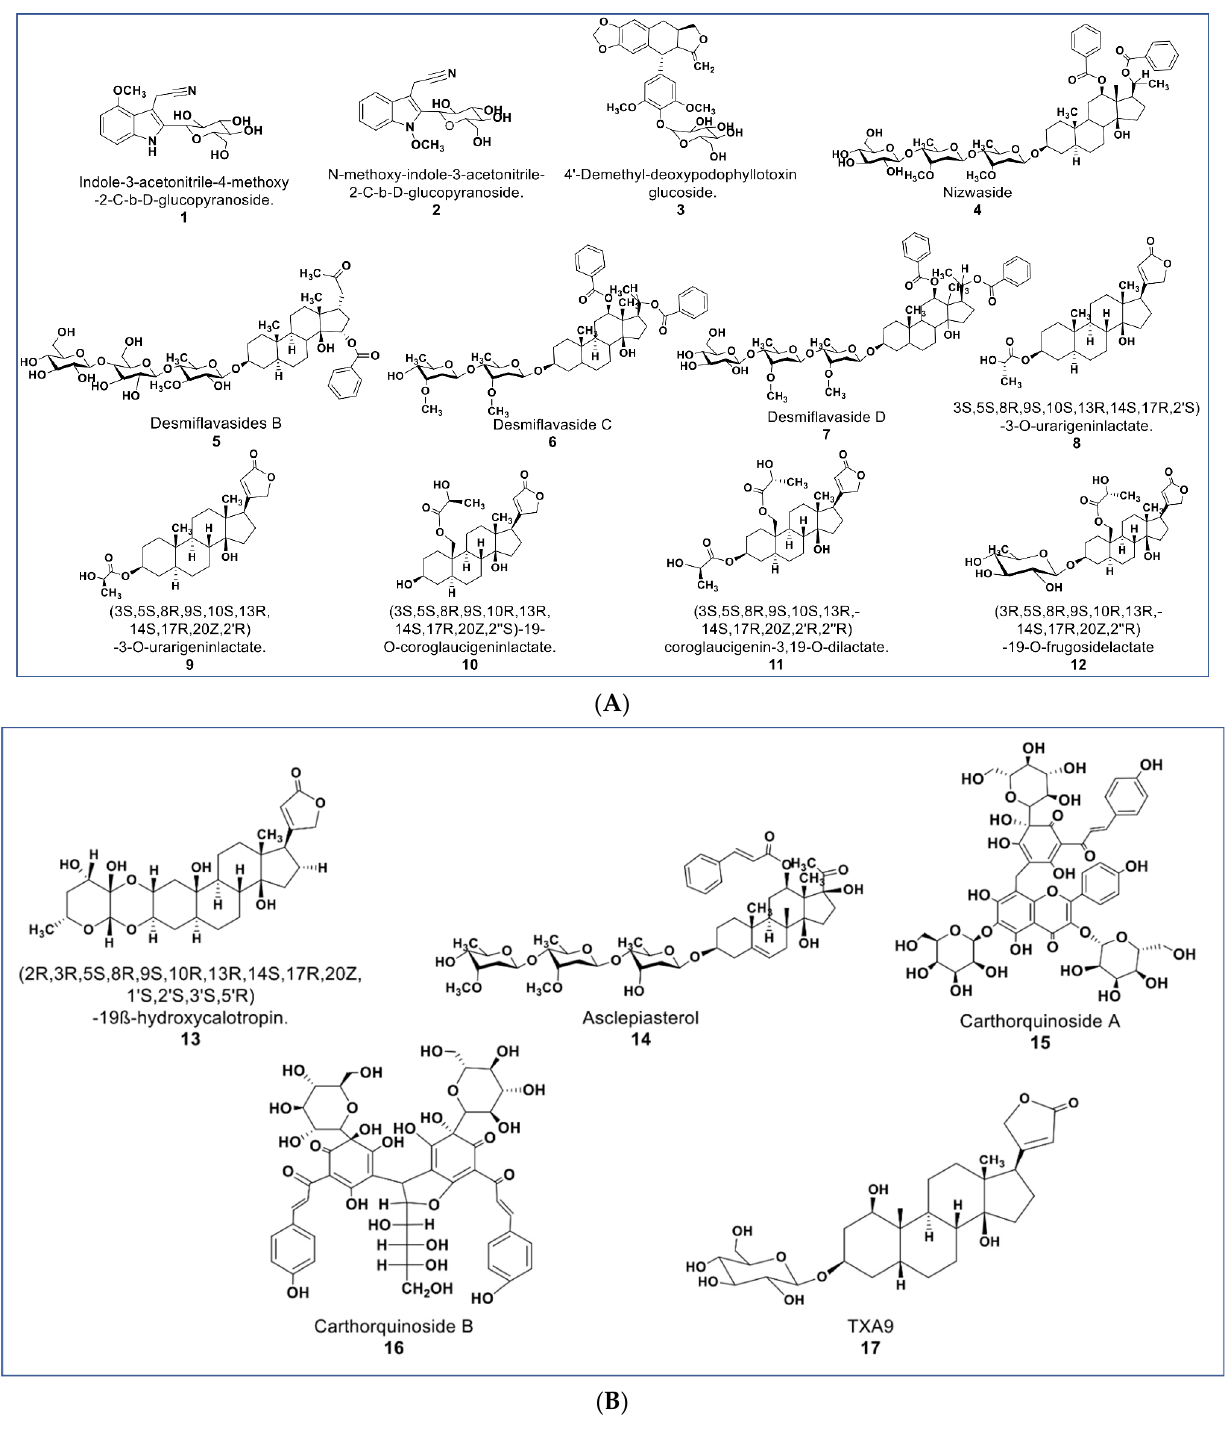
Figure 3. ( A ): Representative members of novel glycosides from various plant sources (compounds 1 – 7 and 12 ). Compounds 8 – 11 are cardenolide lactates isolated from Asclepias curassavica . ( B ): Representative members of novel glycosides from various plant sources (compounds 13 to 17 ).